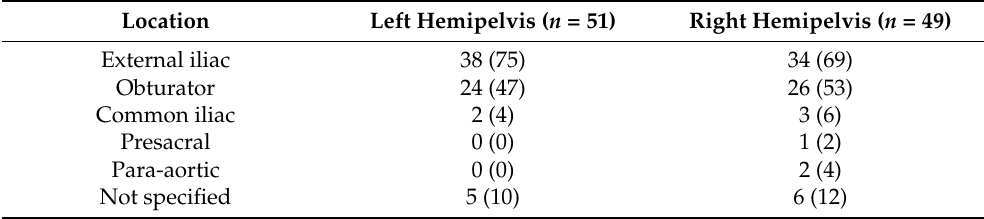
Table 2. Location of detected sentinel lymph nodes in women who underwent sentinel lymph node mapping ( n =